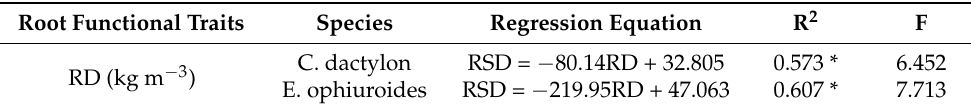
Table 7. Relationship between root density and relative soil detachment rate at slope 15 ◦ for the two species.